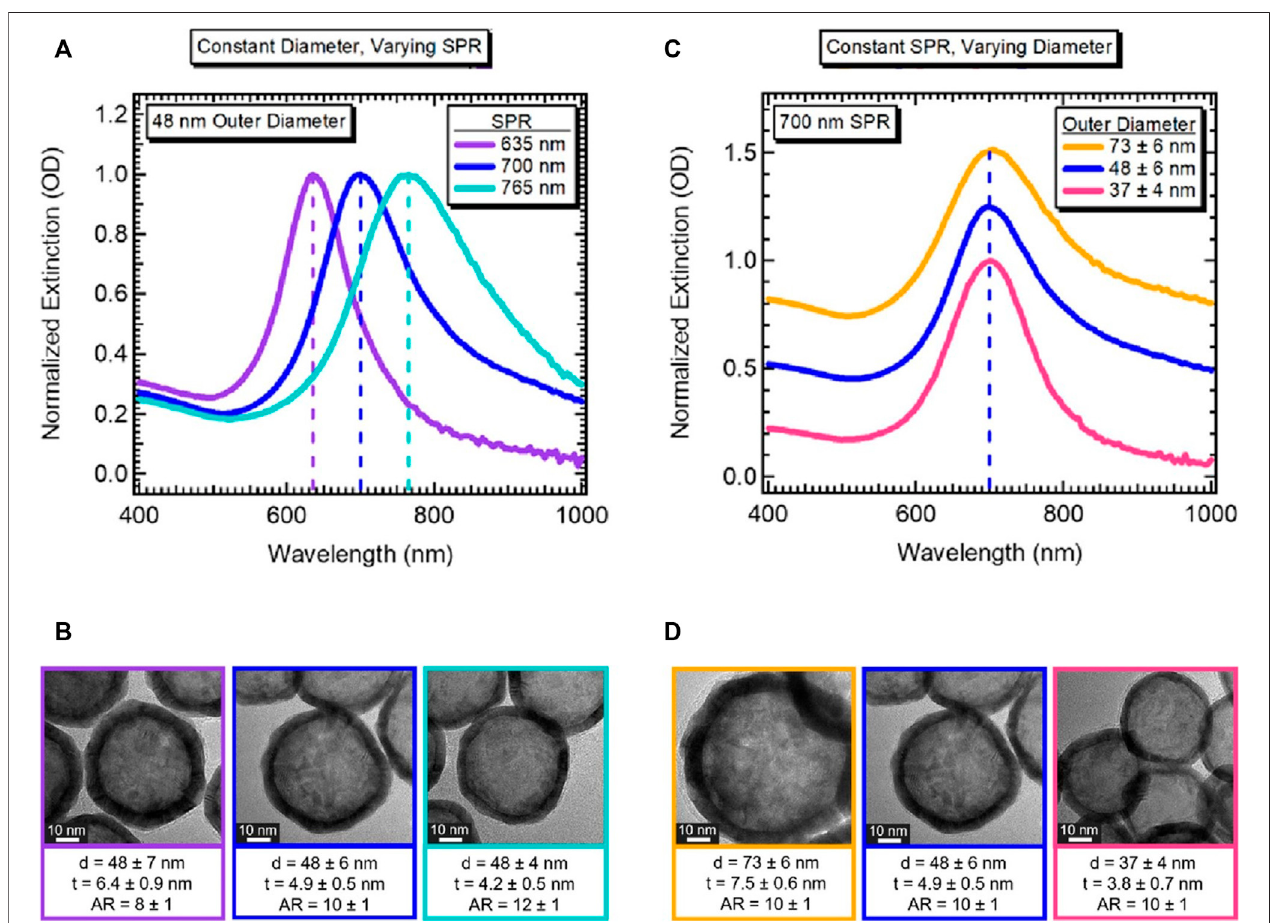
FIGURE 3 | Demonstration of tunability of hollow gold nanospheres. (A) Normalized extinction for hollow gold nanospheres with the same outer diameter but differentLSPRpeaks. (B) Correspondinghigh-resolutiontransmissionelectronmicroscope(HRTEM)imageswithanaveragediameter(d),shellthickness(t),andaspect ratio (AR), as indicated; scale bar 10 nm. (C) Normalized extinction for hollow gold nanospheres with different outer diameters but the same LSPR peak. (D) Corresponding HRTEM images with d , t , and AR values as indicated (scale bar 10 nm). Reprinted with permission from Lindley et al. (2018). Copyright 2018, American Chemical